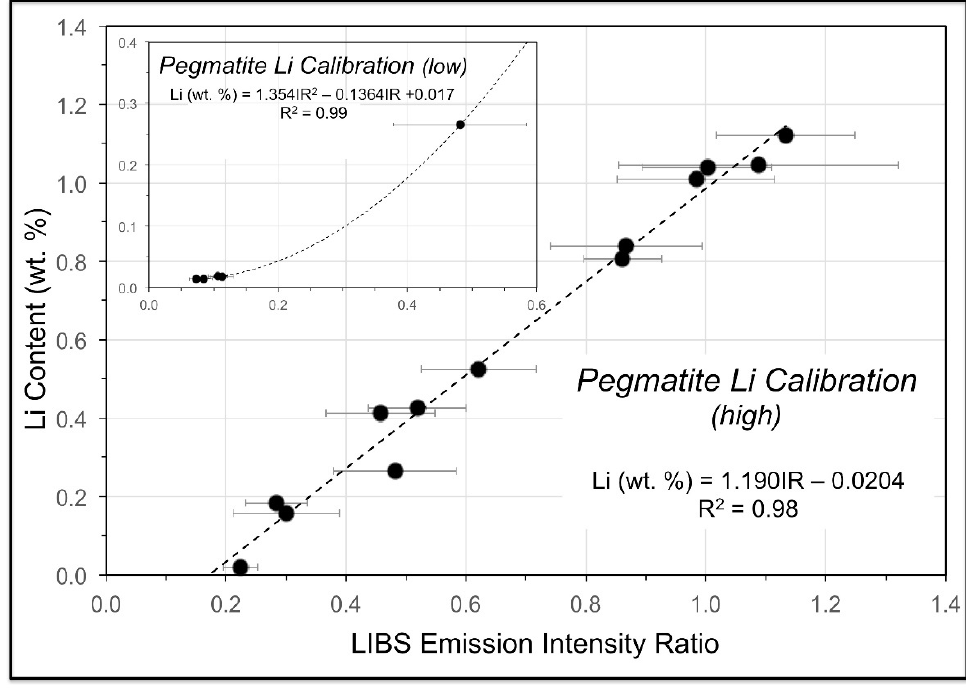
Figure 12. Handheld LIBS calibration curve developed from analysis of 18 pulverized pegmatite core samples from the CLP prospect described in Table A2. The RMSE values for the high and low calibrations are 0.0465% and 0.0021%, respectively.